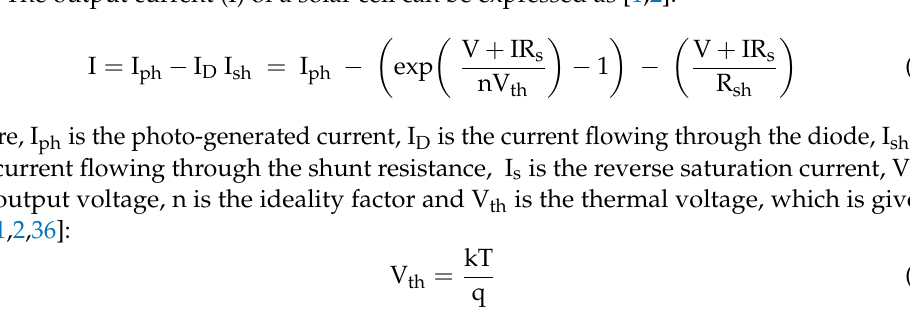
Figure 1. Single diode five-parameter model of a solar cell. (Adapted from [1,2]). The output current (I) of a solar cell can be expressed as [1,2]: